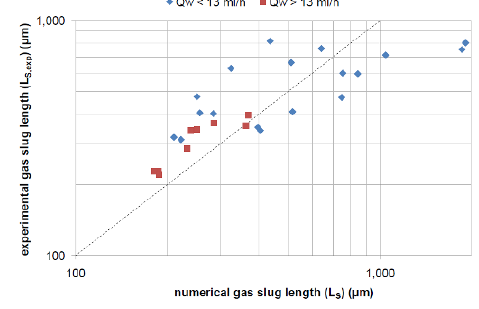
Figure 13. Comparison of numerical and experimental gas slug length